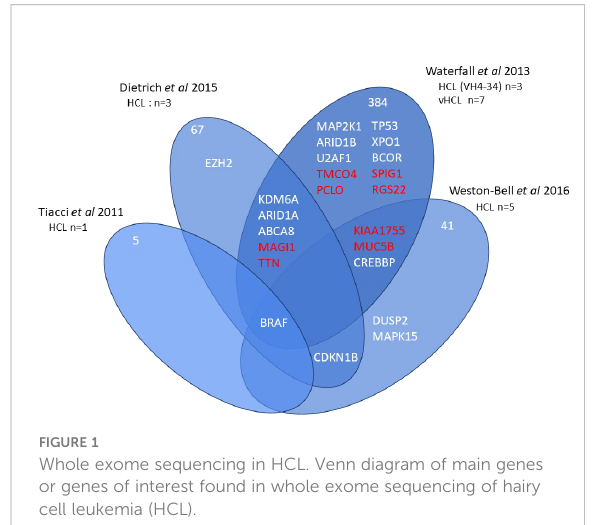
FIGURE 2 Whole exome sequencing in HCL-VH4-34, SBLPN and SDRPL Venn diagram of main genes or genes of interest found in whole exome sequencing of splenic B lymphoma/leukemia with prominent nucleoli (SBLPN), splenic diffuse red pulp lymphoma (SDRPL) and hairy cell leukemia